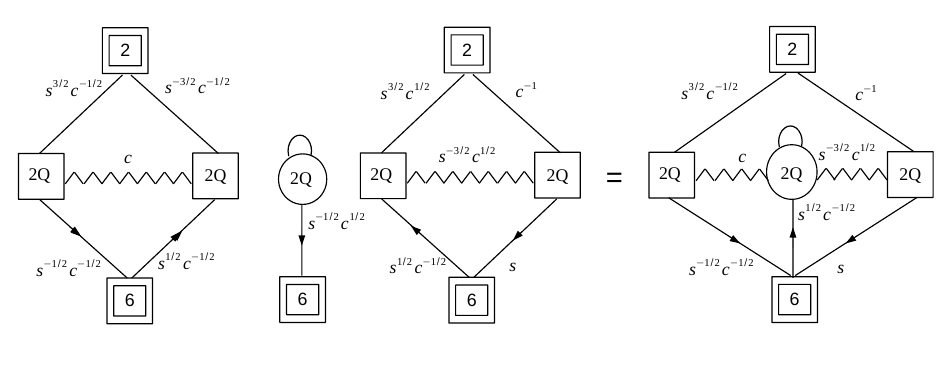
Figure 16: Gluing two basic tubes to form a tube with flux ( 1,1,1,1,1,1,0,0 ) . We avoid drawing arrows for lines connecting USp ( 2 Q ) nodes to SU ( 2 )